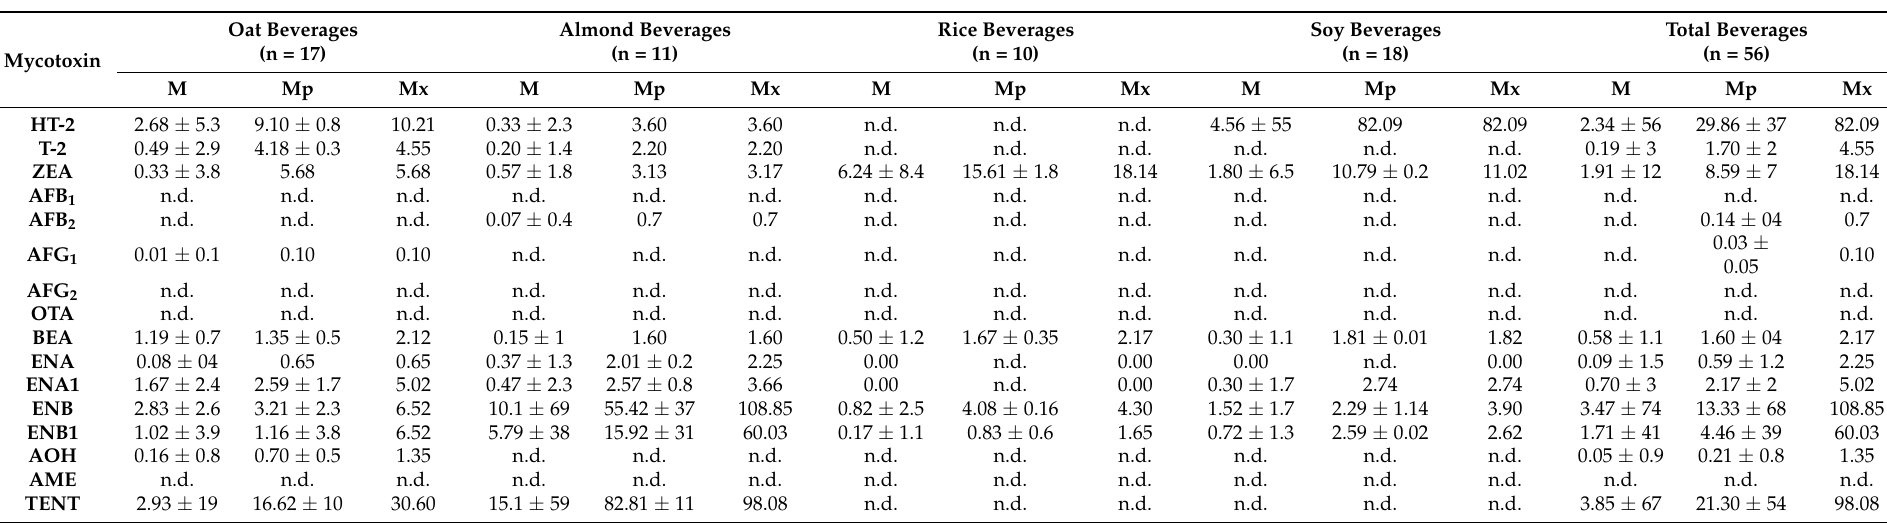
Table 4. Mean of total samples (ng/mL), mean of positive samples (ng/mL) and maximum levels (ng/mL) of detected mycotoxins in analyzed samples.